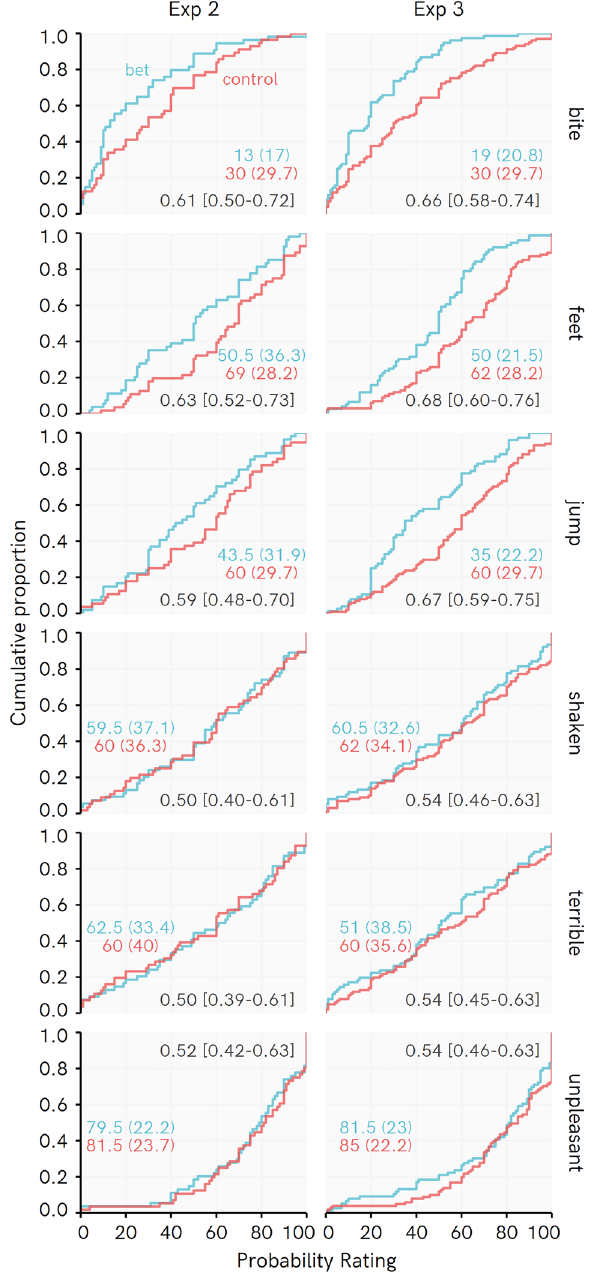
Figure 3. Cumulative distributions for beliefs in Experiments 2 and 3, with raw probability of superiority values and bootstrapped 95% bias corrected accelerated confidence intervals. Colored numbers reflect Median and (Median absolute